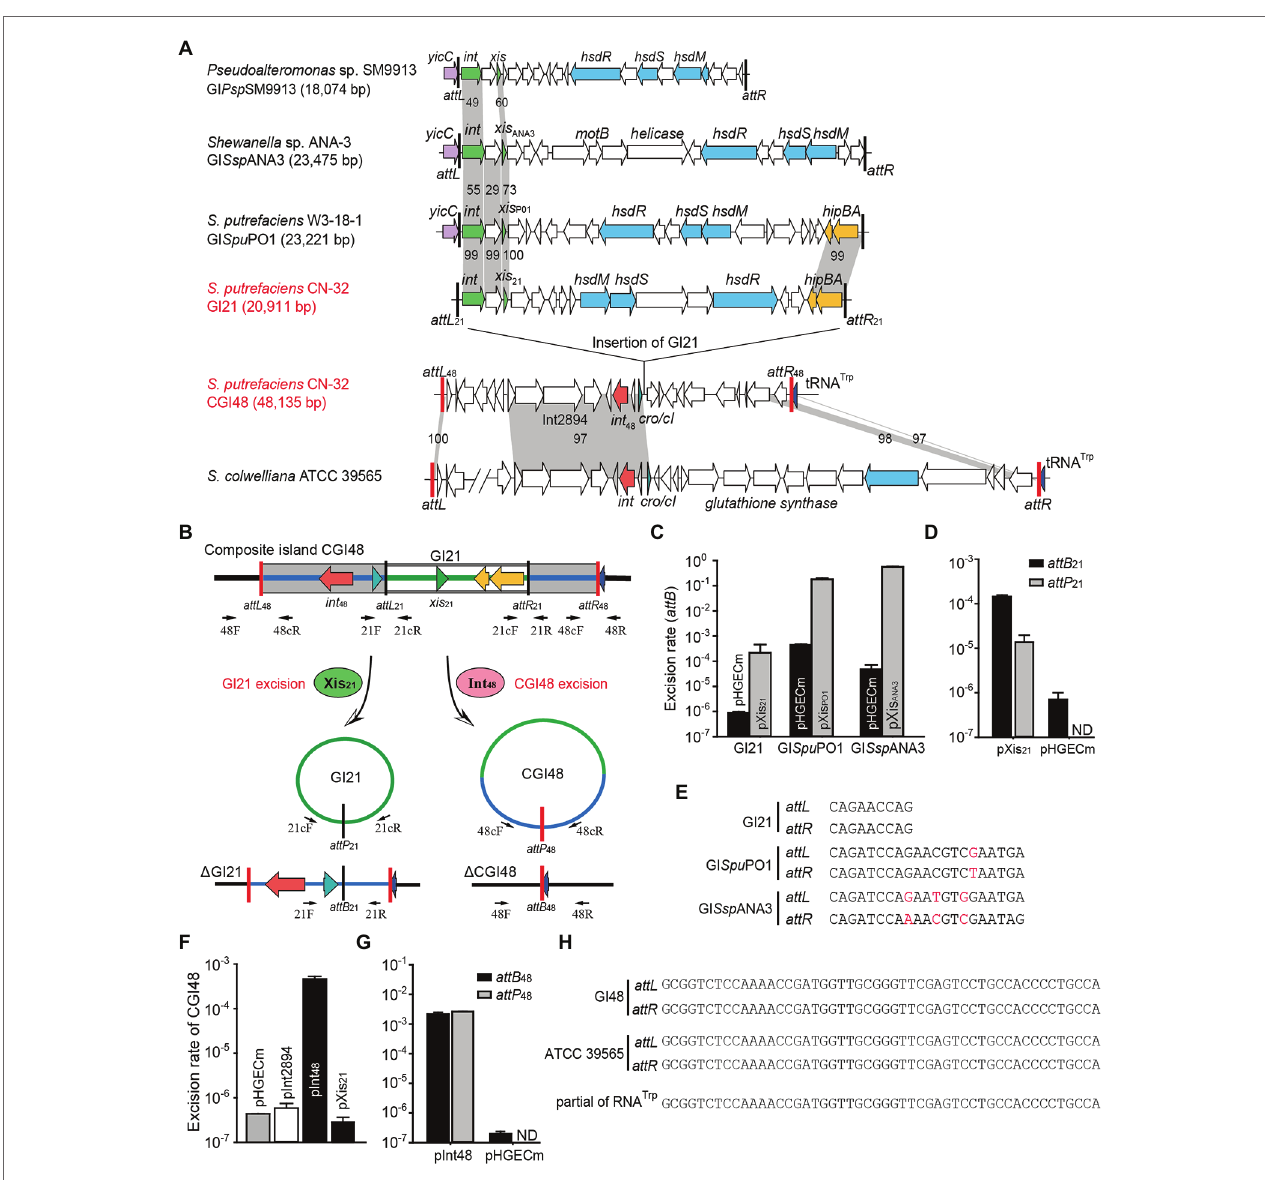
FIGURE 2 | The composite island CGI48 and its component GI21 can be excised from the CN32 genome. (A) Sequence analysis of CGI48 with the related genomic islands. Open reading frames with putative functions are shown in different colors. The attL and attR attachment sites of CGI48 and GI21 are shown in red and black, respectively. The sequence of the GI integrated into tRNA Trp of ATCC 39565 genome was in L876DRAFT_scaffold 00018.18_C (82,217–85,620 bp) to scaffold 00033.33_C (1,478–38,068 bp). (B) Schematic of the excision of CGI48 and GI21. (C) The excision rate of GI21, GI Spu PO1, and GI Ssp ANA3 was quantified when cognate excisionase was overexpressed. (D) Comparison of the excision rate ( attB 21 ) and circular form of GI21 ( attP 21 ) in CN32 when Xis21 was overexpressed. ND indicates not detected. (E) Sequence comparison of the attachments of GI21, GI Spu PO1, and GI Ssp ANA3. (F) The excision rate of CGI48 when Int 48 was overexpressed. (G) Comparison of the excision rate ( attB 48 ) and circular form of CGI48 ( attP 48 ) in CN32 when Int48 was overexpressed. ND indicates not detected. (H) Sequence comparison of the attachment sites of CGI48 and GI in ATCC 39565 compared with the 3 ′ end of RNA Trp in Shewanella